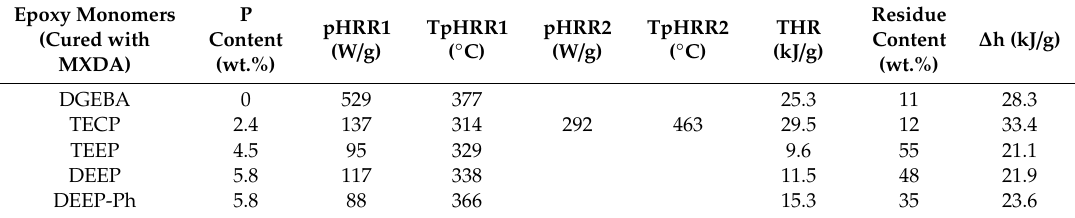
Table 2. Main data from pyrolysis-combustion flow calorimeter